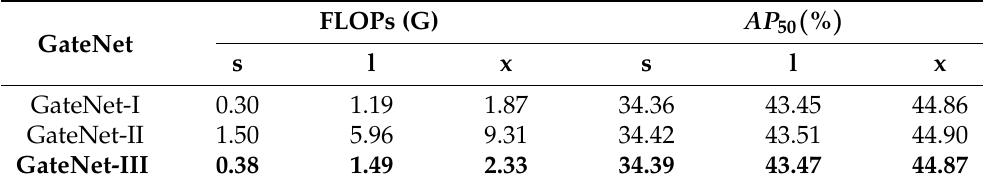
Table 3. Comparison of different GateNets in term of computation cost (measured by “FLOPs (G)”) and detection accuracy (measured by “ AP 50